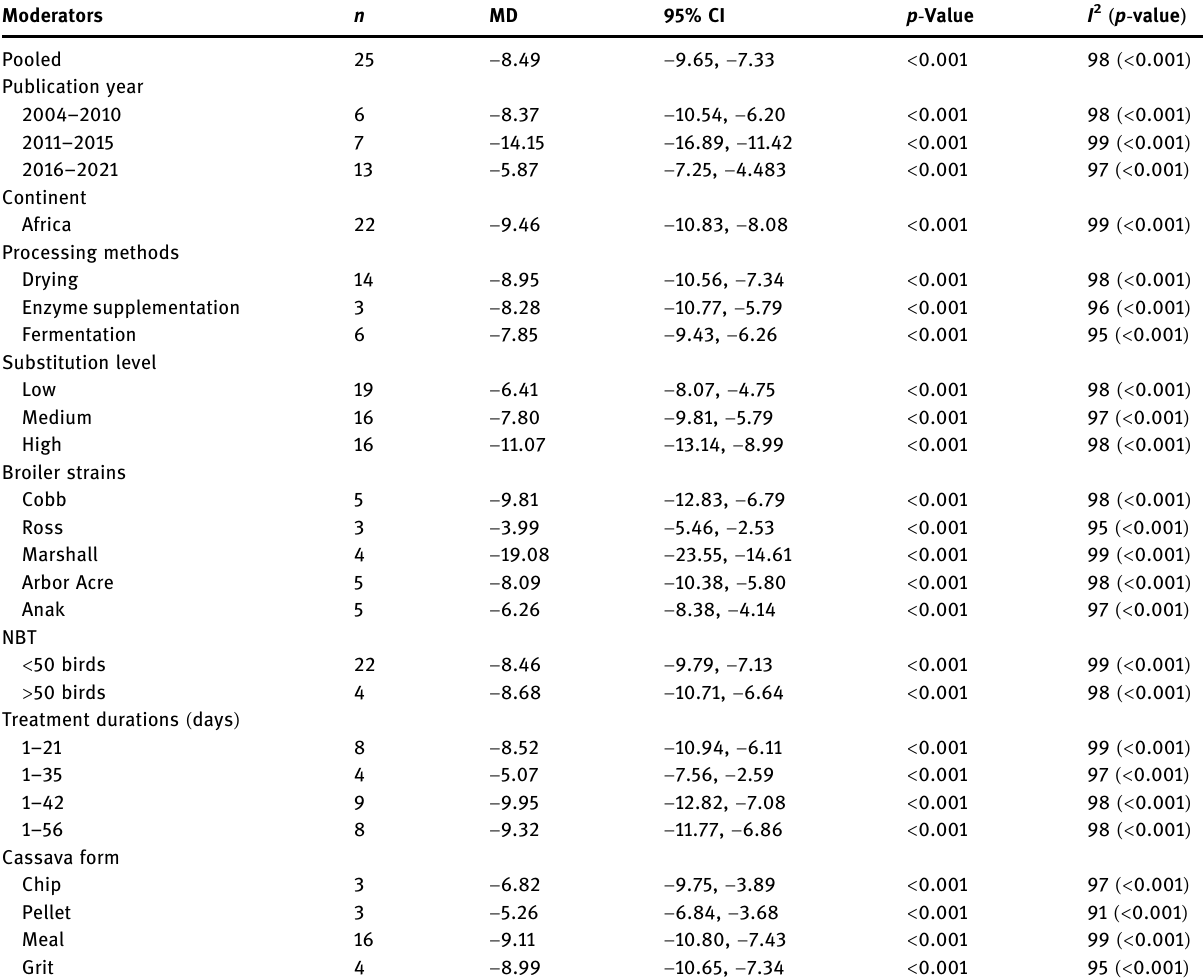
Table 4: E ff ect of cassava on BWG in broiler chickens Moderators